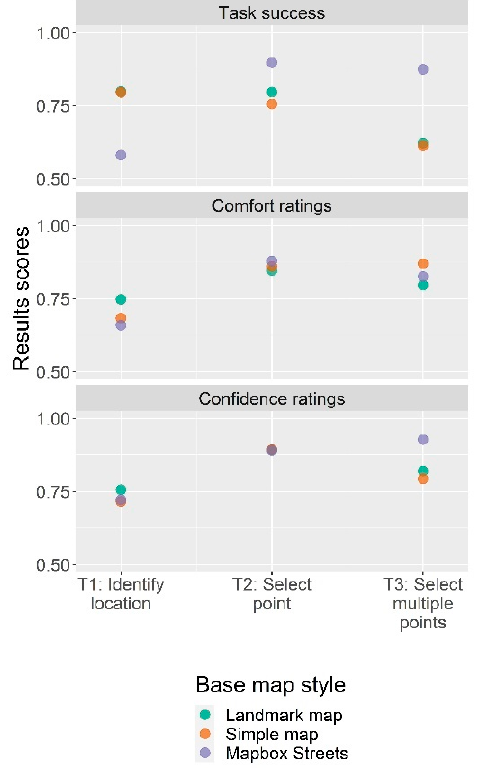
Figure 11. Task success, comfort, and confidence ratings of base map by map-reading tasks.